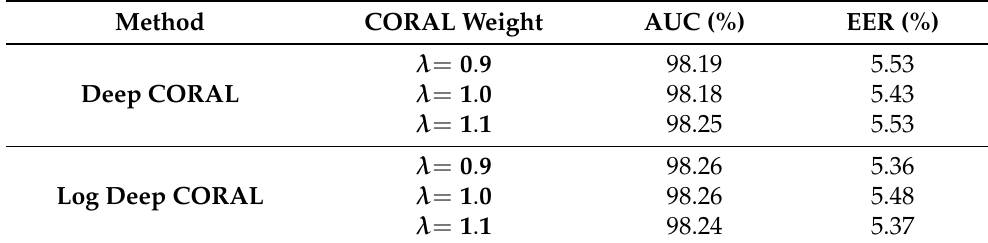
Table 6. AUC (%) and EER (%) for FS02 development partition using Deep CORAL and Log Deep CORAL domain adaptation setups using various λ weights.